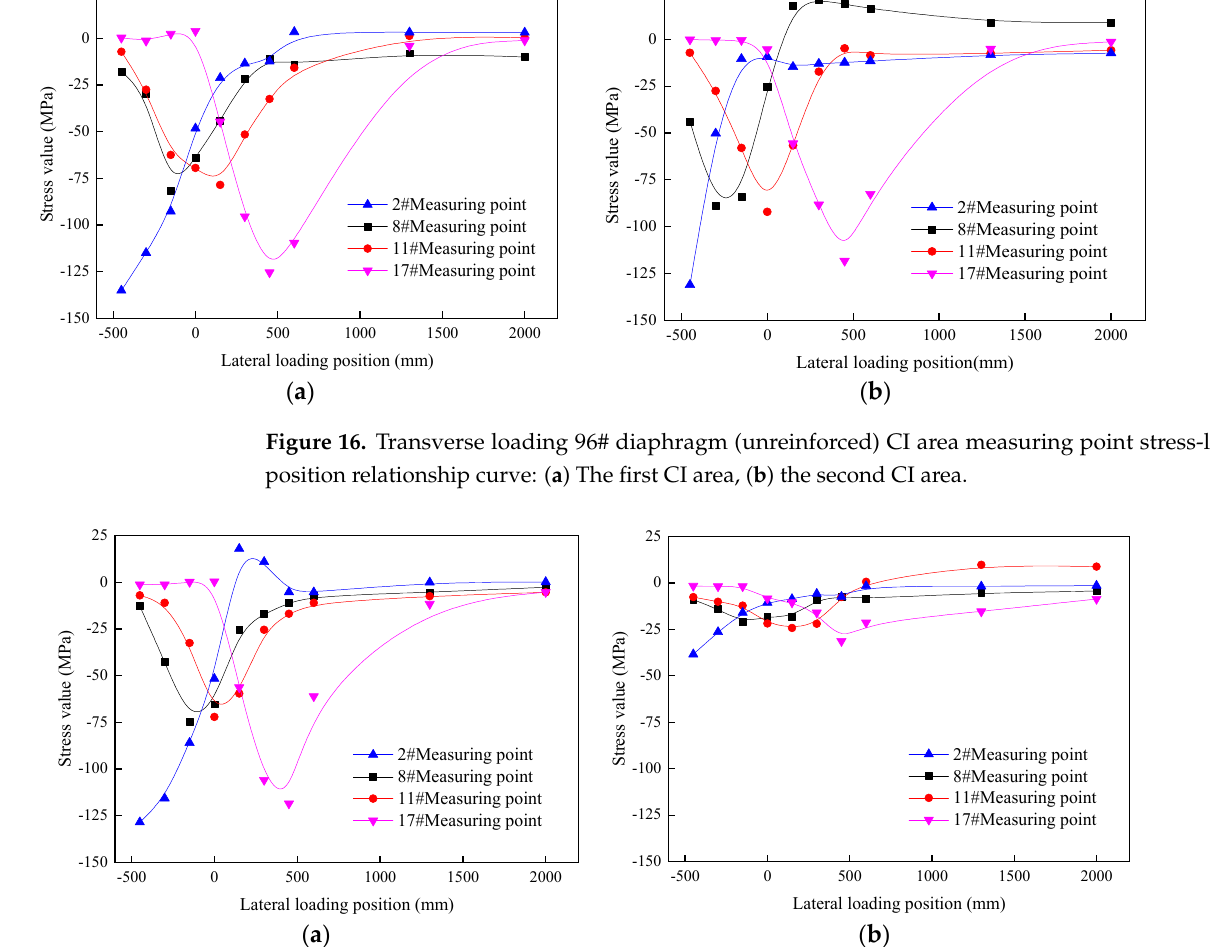
Figure 16. Transverse loading 96# diaphragm (unreinforced) CI area measuring point stress-load position relationship curve: ( a ) The first CI area, ( b ) the second CI area.